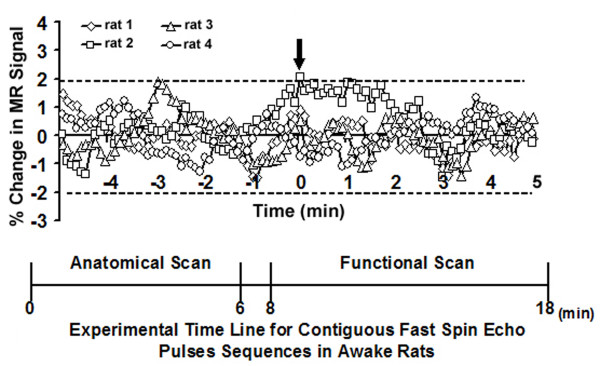
Controlling for drift. Shown are data from four experiments imaging a fully conscious rat without presentation of a stimulus. The arrows denote the time when a stimulus would have been introduced in a typical imaging session. The schematic shown below outlines the time course of the total scanning session including the initial high resolution anatomical data set. These data would control for any drifts associated with the instrumentation or change in the animal's physiology.